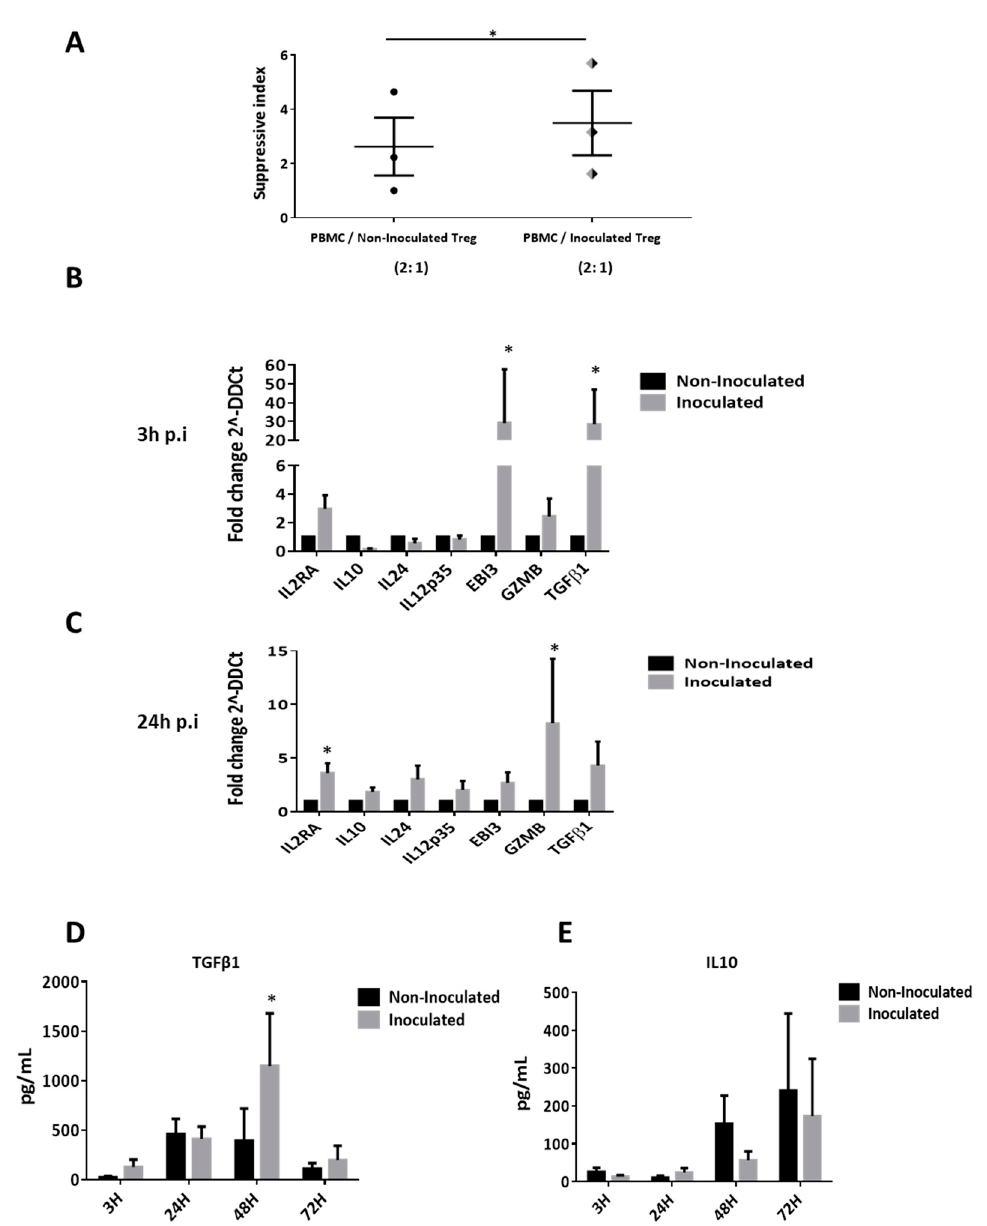
Figure 5. HCV inoculation increases the suppressive activity of Tregs. Tregs were pre-incubated for 24 h with HCV virions produced in cell culture (HCVcc) before co-cultured with autologous PBMC at 2:1 ratio in activated conditions ( A ). Results are expressed as mean values of triplicates of three independent experiments and presented in index of suppression ± SEM bars. Mechanistic analyses highlight an increase expression of IL-2RA, IL-10, IL-24, IL-12p35, EBI3, GZMB and TGF- β 1 mRNA in inoculated Tregs at 3 h p.i ( B ) and 24 h p.i ( C ). Results are presented as means of four independent experiments in inoculated Tregs (light grey bars) versus non inoculated Tregs (dark bars). Gene expressions are normalized by using GADPH, beta-actin, 18s and HRPT mRNA as housekeeping-genes and the results are expressed in fold change (2 – ∆∆ Ct ) ± SEM bars. Secretion of immunosuppressive cytokine TGF- β 1 ( D ) and IL-10 ( E ) was evaluated at di ff erent time point after HCV inoculation on three independent experiments. Results are expressed in pg / mL ± SEM bars comparing secretion by inoculated Tregs (light grey bars) versus non-inoculated Tregs (dark bars). p ≤ 0.05